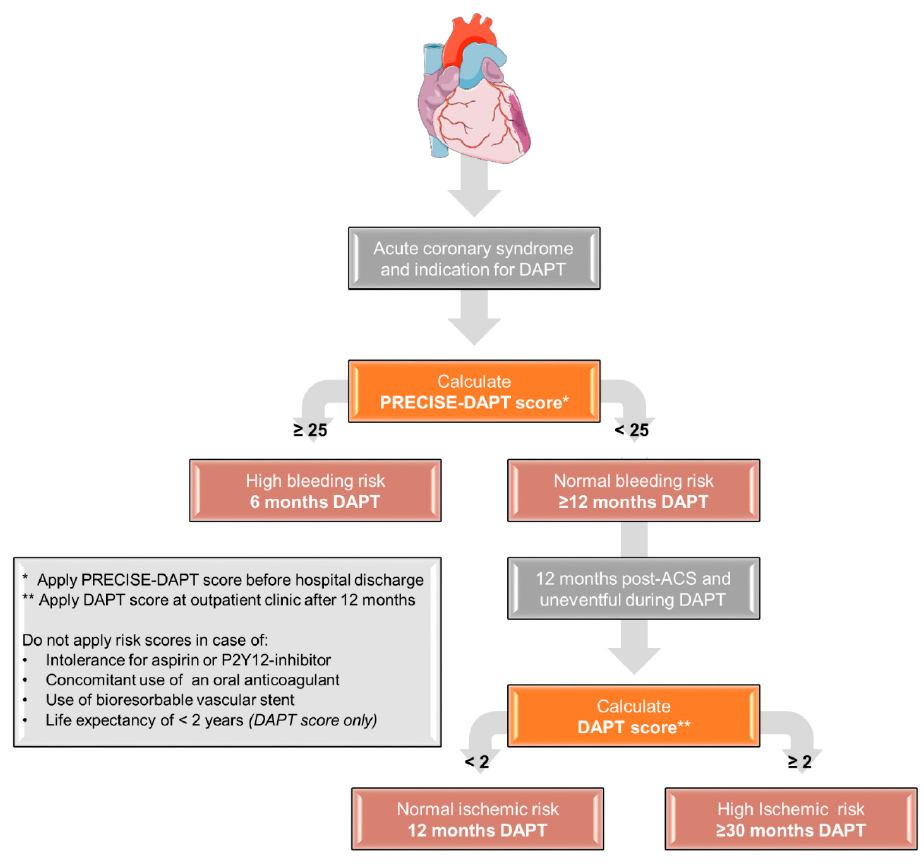
Figure 3. Flowchart illustrating decision-making regarding the optimal treatment duration with dual antiplatelet therapy using risk scores. Abbreviations: ACS, acute coronary syndrome; DAPT, Dual AntiPlatelet Therapy.